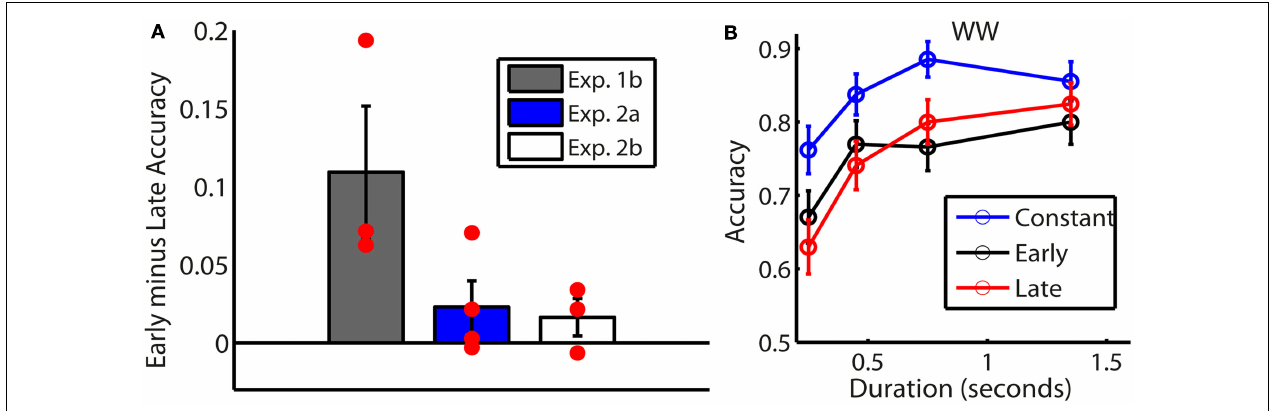
Red circles correspond to individual data. Error bars correspond to 1 SE. (B) Accuracy as a function of stimulus duration for participantWW in Experiment 2A. Constant, early, and late conditions are shown in blue, black, and red respectively. Error bars correspond to 95%